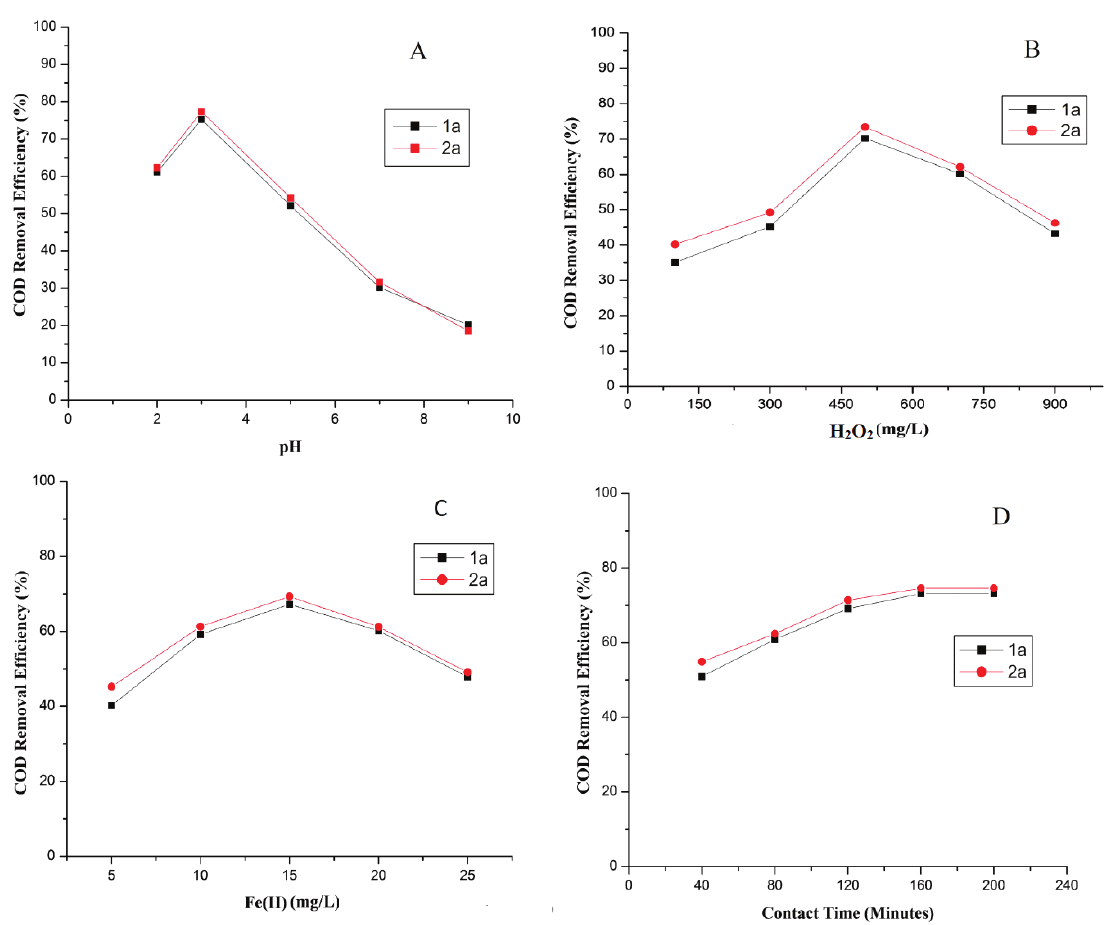
O (B), Fe 2+ (C) and contact time (D) on COD removal efficiency of UV absorbers (1a-2a) in Fenton oxidation. 2 2